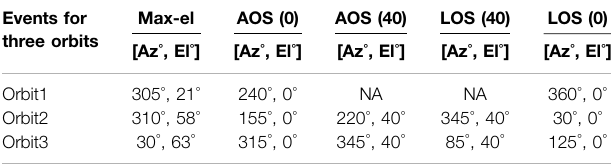
TABLE 6 | Coordinates of the satellites space